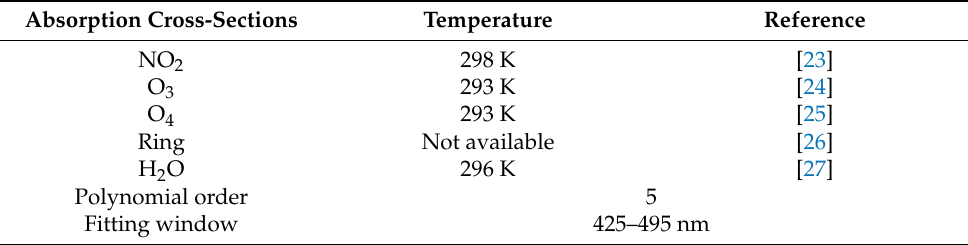
Table 1. The main settings used for the NO 2 spectral analysis using QDOAS software. Absorption